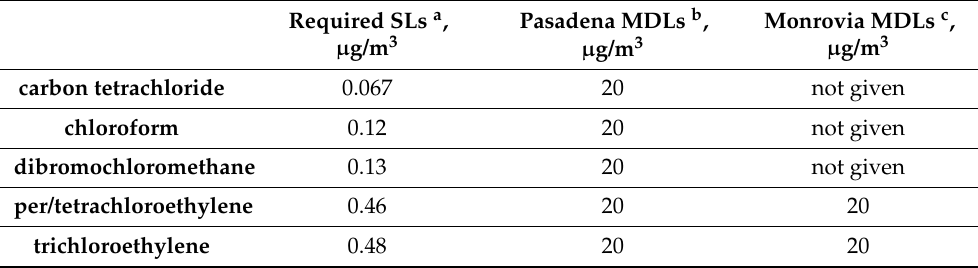
a Stricter SLs take precedence, given federal/state differences. CT/PCE SLs, per California [60]; others from US